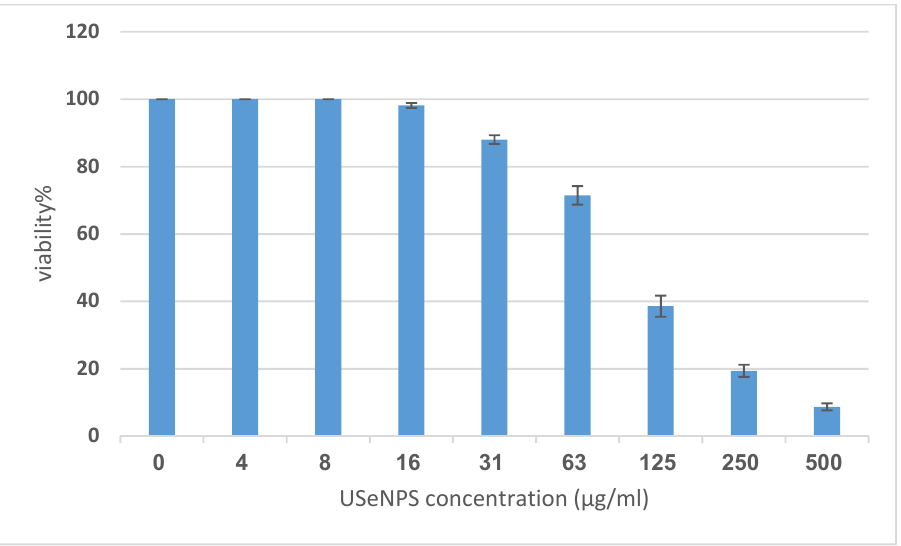
Figure 9. The cytotoxicity of USeNPS against HepG2 with 50% cell cytotoxic concentration IC 50 = 103.36 ± 2.93 µg/mL.